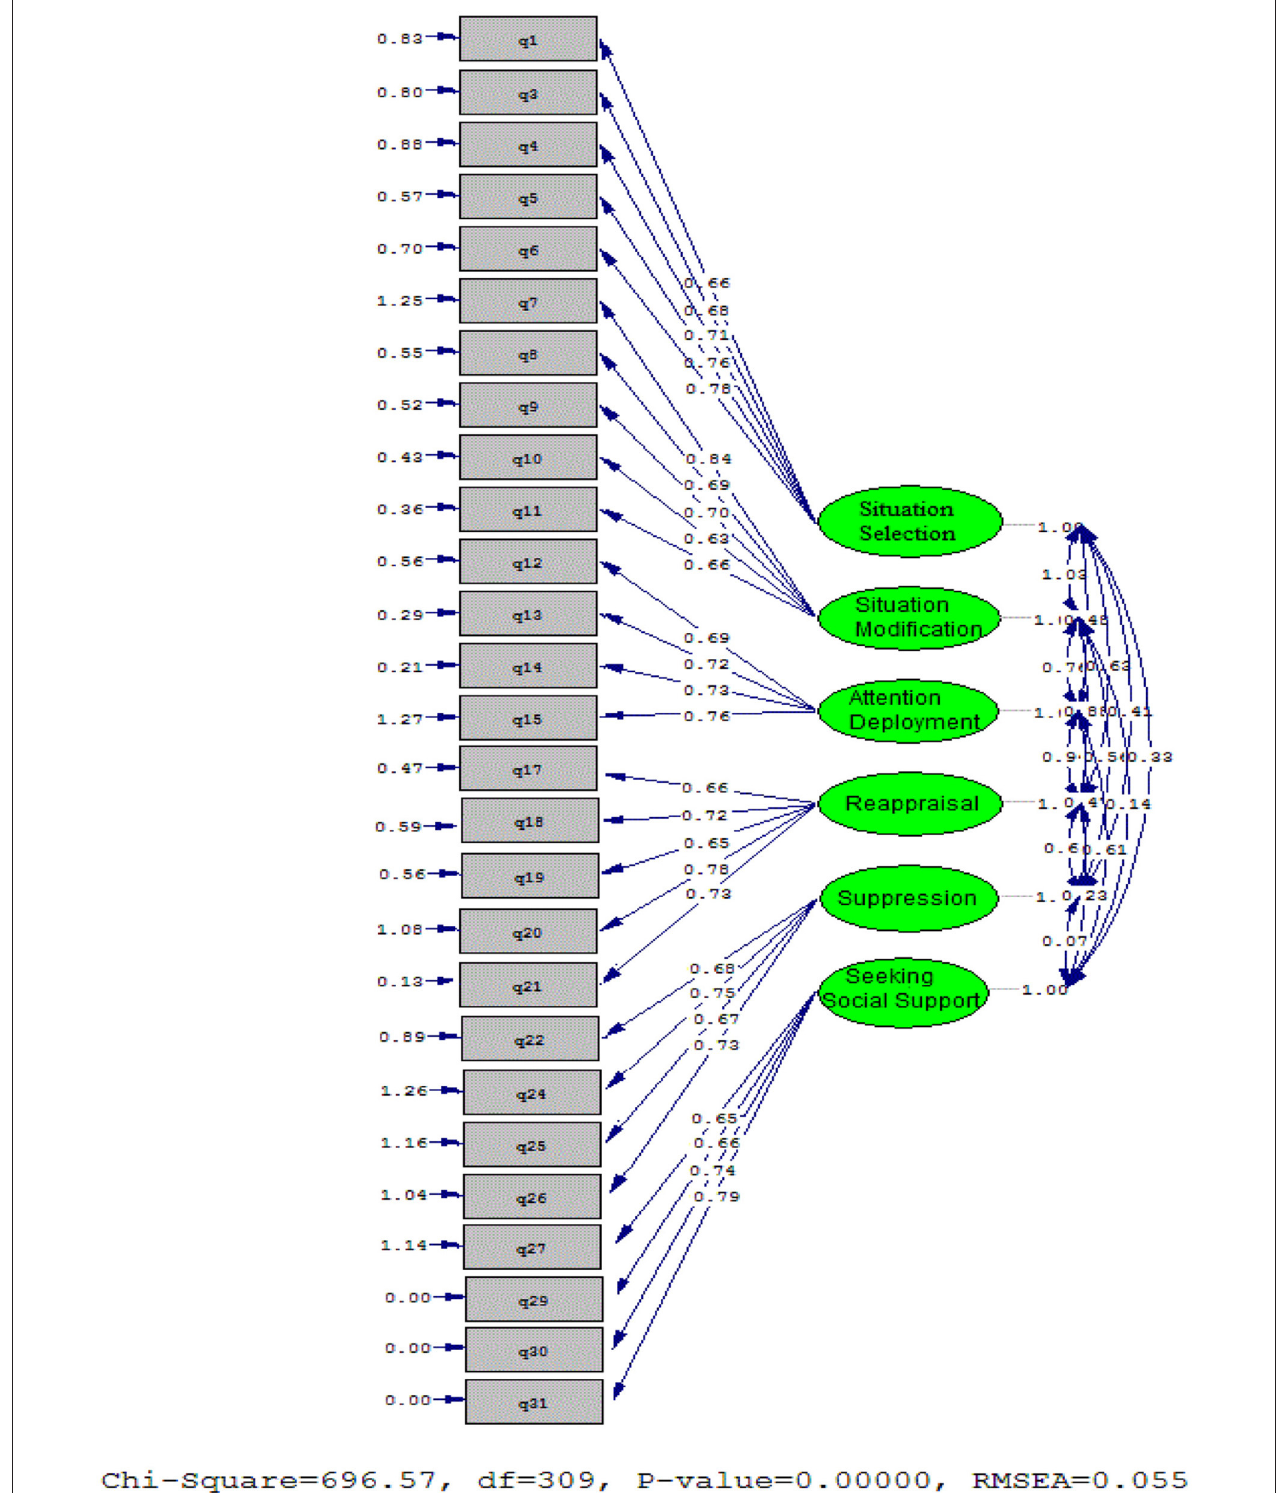
FIGURE 1 | The schematic representation of language teacher emotion regulation and the corresponding items.